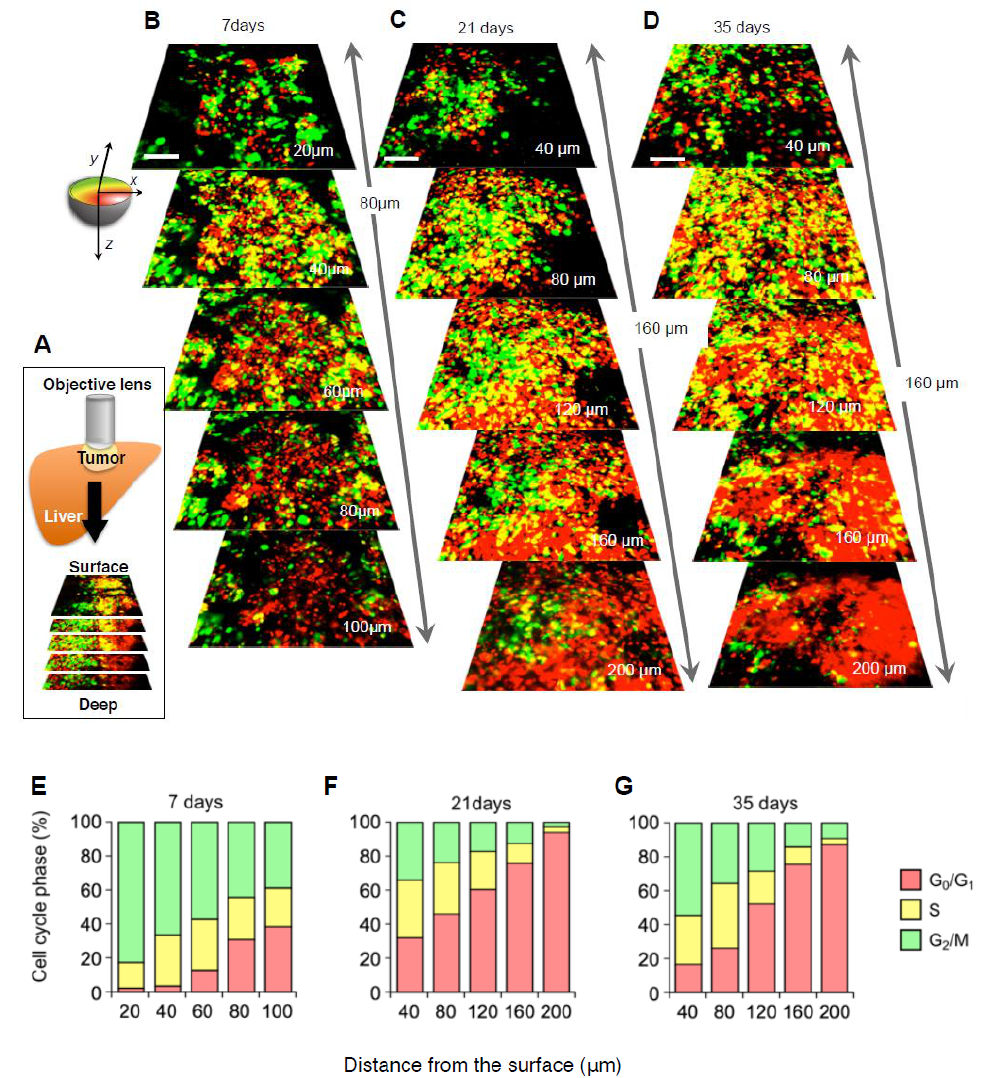
Figure 2. Intravital cell cycle imaging in FUCCI-expressing tumors shows the cell-cycle phase distribution of cancer cells at the tumor surface and center. High-resolution images (tile scan) were obtained with a 20 × (0.95 numerical aperture immersion) objective lens. To monitor the cell-cycle distribution of cancer cells during tumor growth, three-dimensional images (z stacks) of the same tumor at day 7, 28, and 90 post-implantation were used. ( A ) The schematic diagram shows the method of longitudinal intravital CLSM imaging of FUCCI-expressing MKN45 gastric-cancer cells growing in the liver using a skin-flap window. ( B – D ) FUCCI-expressing MKN45 cells were implanted directly in the liver of nude mice and imaged at 7 days ( B ), 21 days ( C ), and 35 days ( D ). ( E – G ) Histograms show the distribution of FUCCI-expressing cells at different distances from the surface. The number of cells in each cell-cycle phase was assessed by counting the number of cells of each color at the indicated time points and depth. The percentage of cells in the G 2 /M, S, and G 0 /G 1 phases of the cell cycle are shown. Scale bars represent 100 µ m. Data are means ± SD. (Reproduced from [46] with the permission of Taylor and Francis).